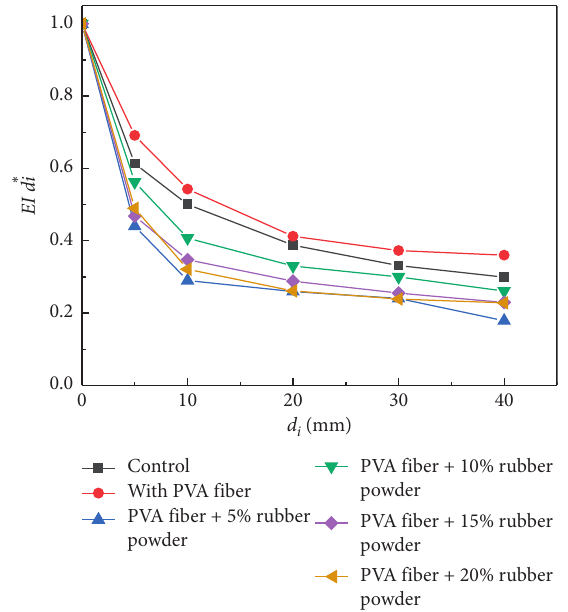
Figure 11: Relationship between dynamic stiffness of section bending and control